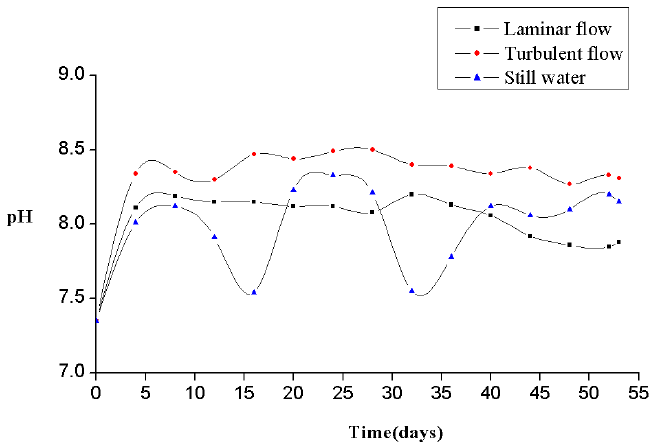
Figure 6. Change in pH value in different periods of different circulating aqueous solutions.